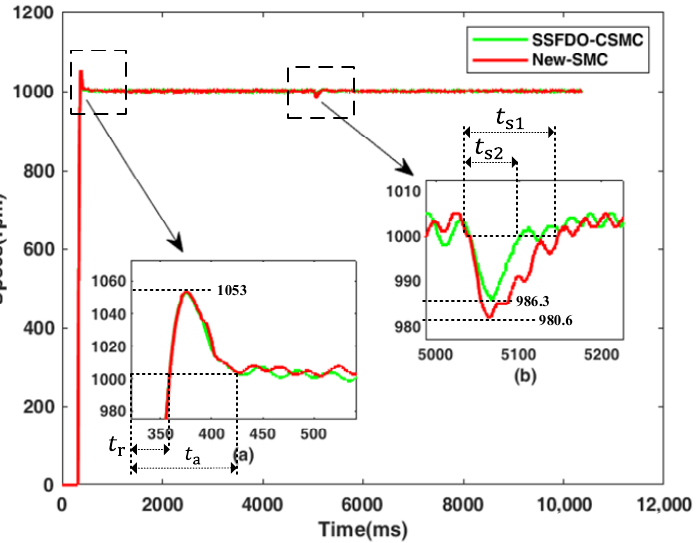
Figure 13. Actual speed response with or without observer: ( a ) starting performance, ( b ) disturbance rejection ability. Table 4. Comparison of the simulation and experimental results with and without an observer.